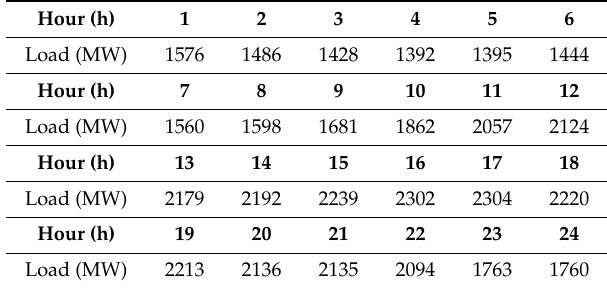
Table A4. Hourly Load Data for the 17-unit